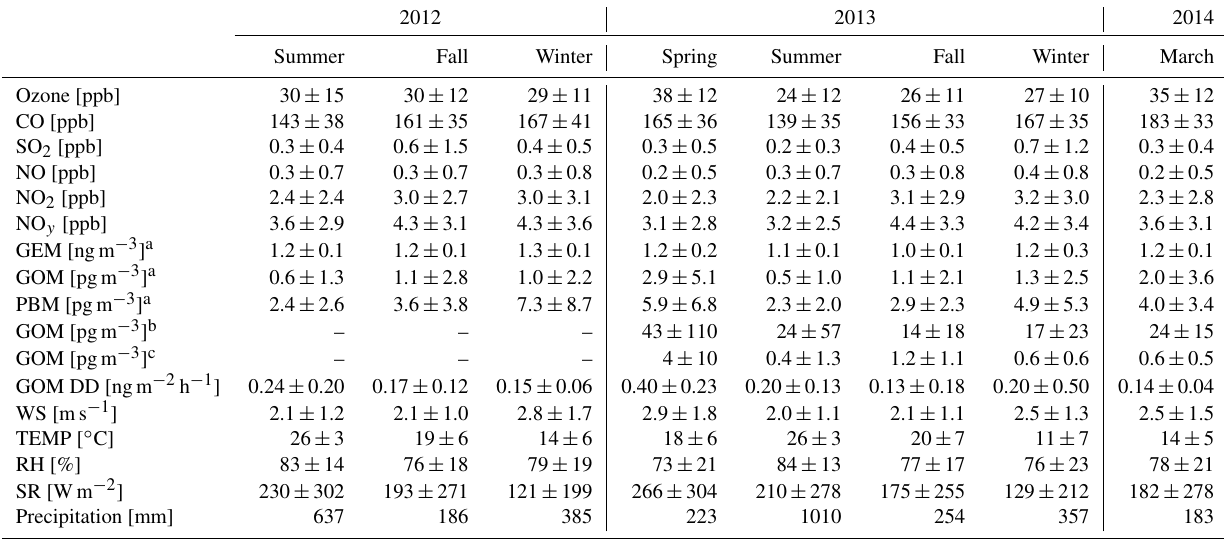
Table 1. Overall seasonal average of criteria air pollutants, GEM, PBM, GOM (measured using three different methods) concentration, GOM dry deposition (DD), and meteorological data at